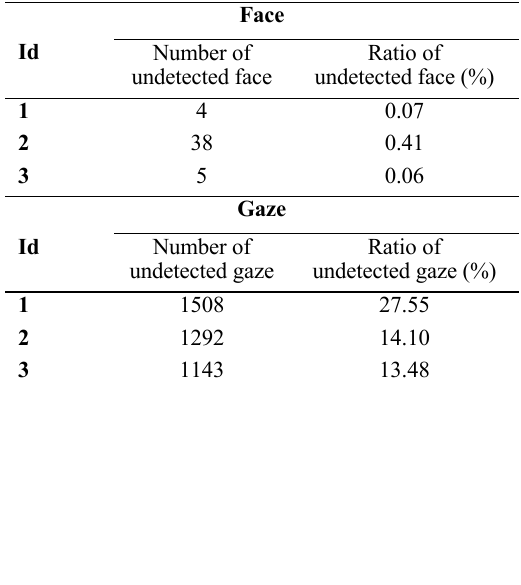
Table 6. The number and ratio of the image-frames that face and gaze could not be detected.